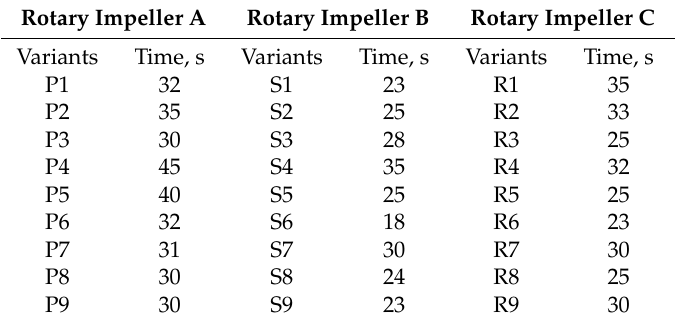
Figure 8. Results of residence time distribution (RTD) curves determination on water model of batch reactor for aluminum refining, by argon blowing, for three different impellers, for chosen processing parameters based on visualization results: ( a ) rotary impeller A; ( b ) rotary impeller B; ( c ) rotary impeller C. Table 6. Time of mixing gas bubbles with water estimated on the base of RTD